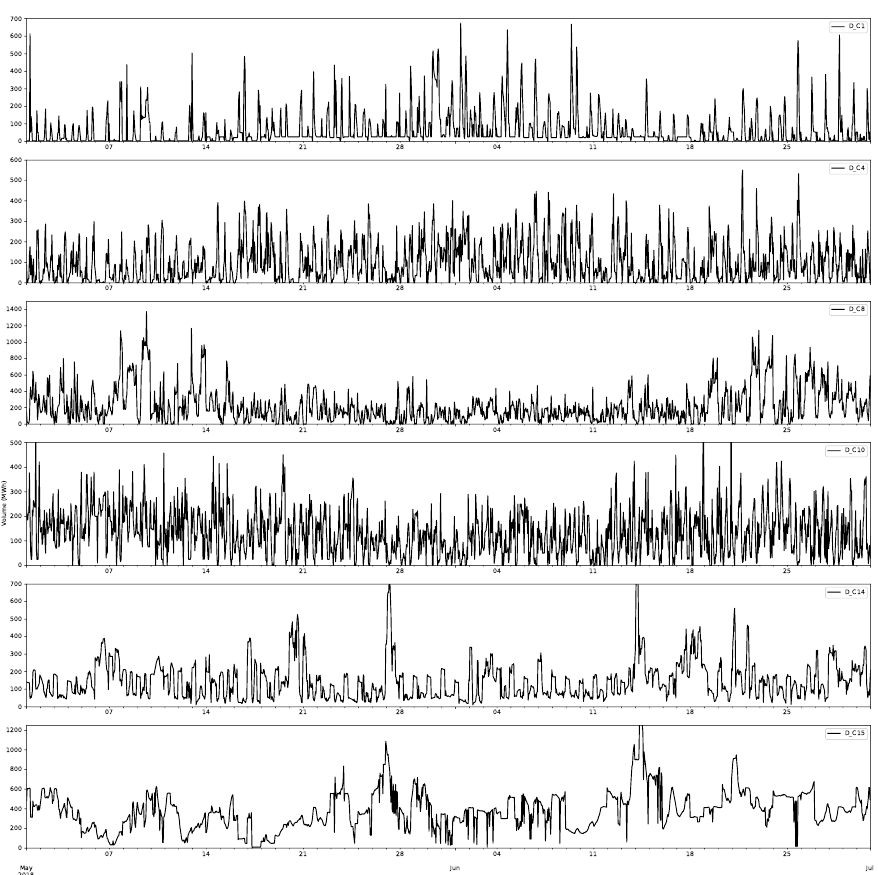
Figure 7. Samples of the volume time series for other demand